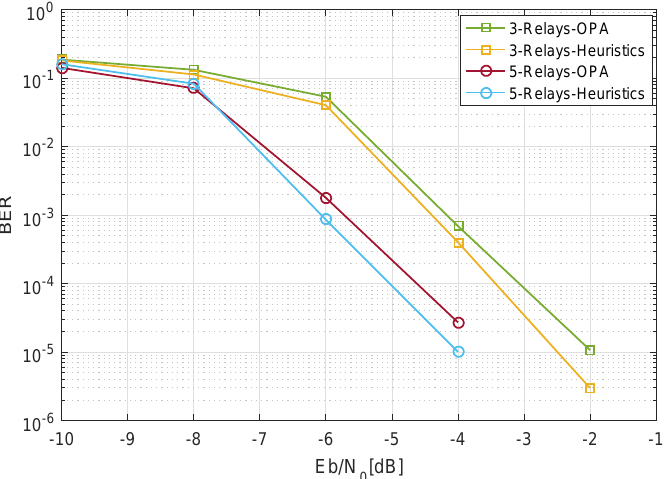
Figure 10. OPA compared with heuristics based approach, LDPC codeword length = 312, m 1 = m 2 = 3, 4-QAM, and C R =